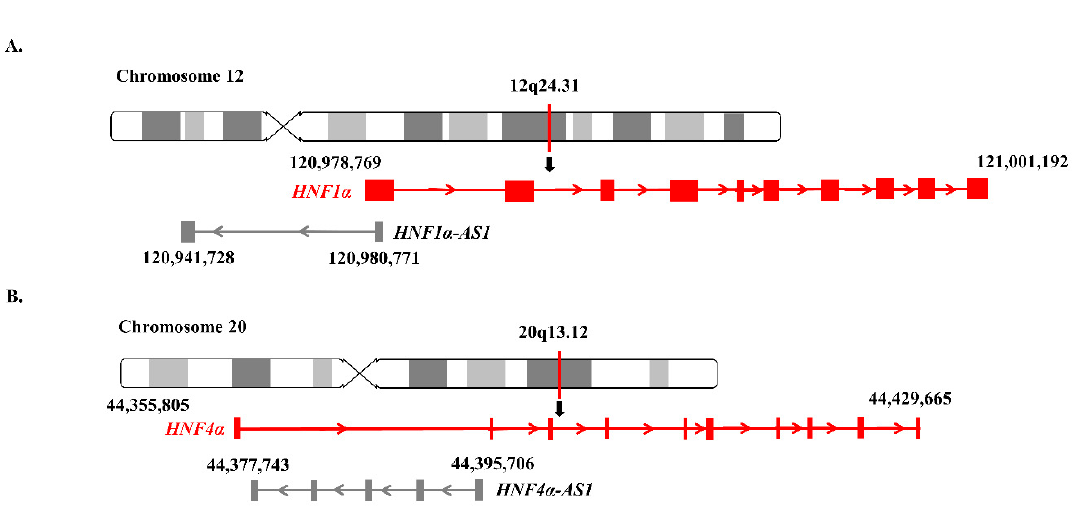
Table 2. The coding potentials of HNF1 α -AS1 and HNF4 α -AS1. RNA